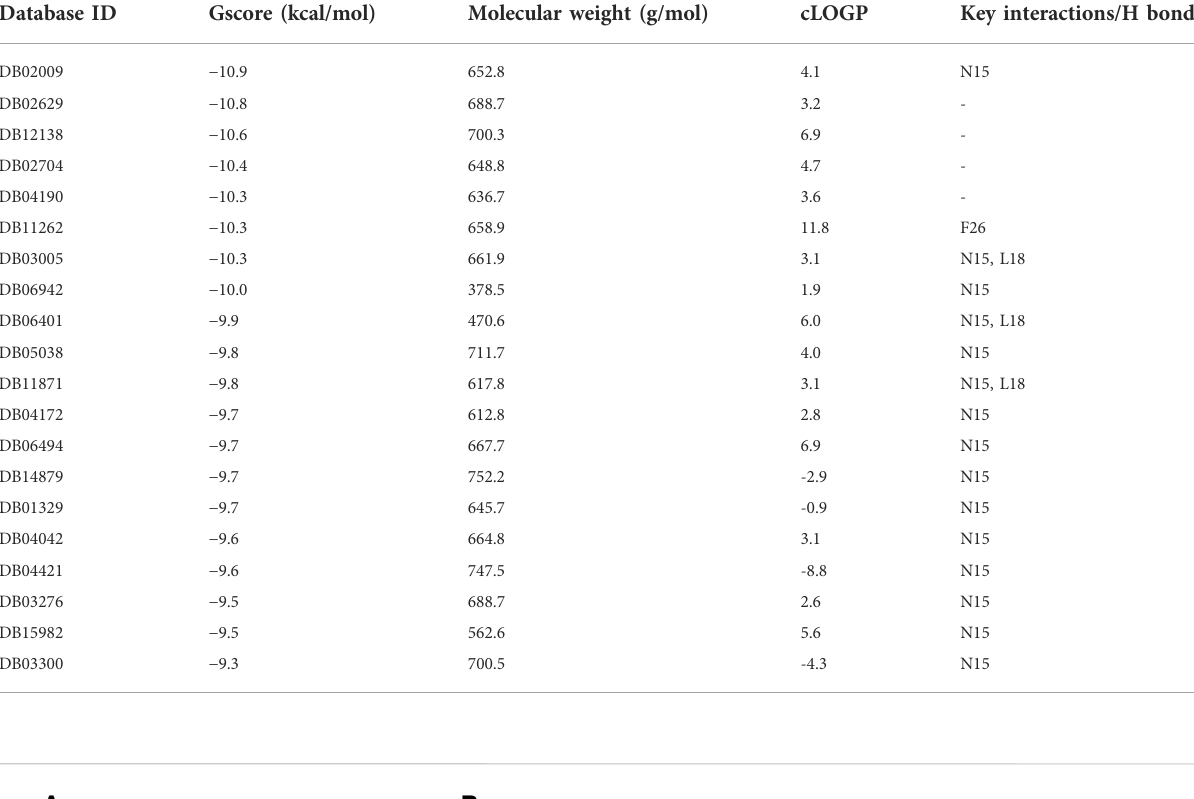
TABLE 1 List of 20 top-ranked compounds and their Glide score (gscore) and the key interactions formed with the E protein.